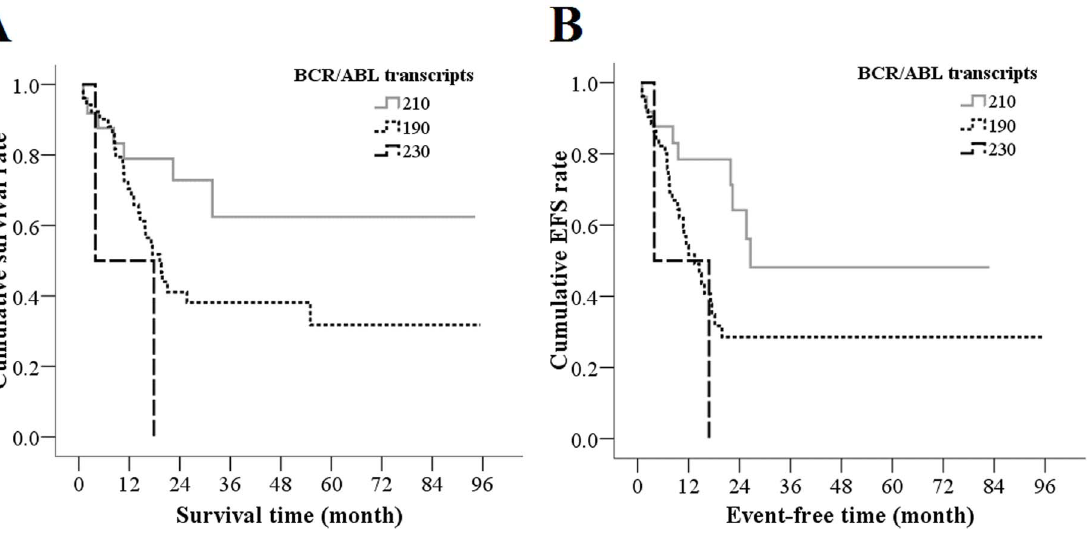
Figure 2. Prognosis for OS (A) and EFS (B) in Various BCR/ABLTranscripts Groups. The log-rank tests showed improved prognosis as demonstrated in the OS and EFS curves for those patients with BCR/ABL transcripts 210 compared to those with BCR/ABL transcripts 190 and 230 ( P 5 0.039 and 0.016 for OS curves, and 0.029 and 0.028 for EFS curves,